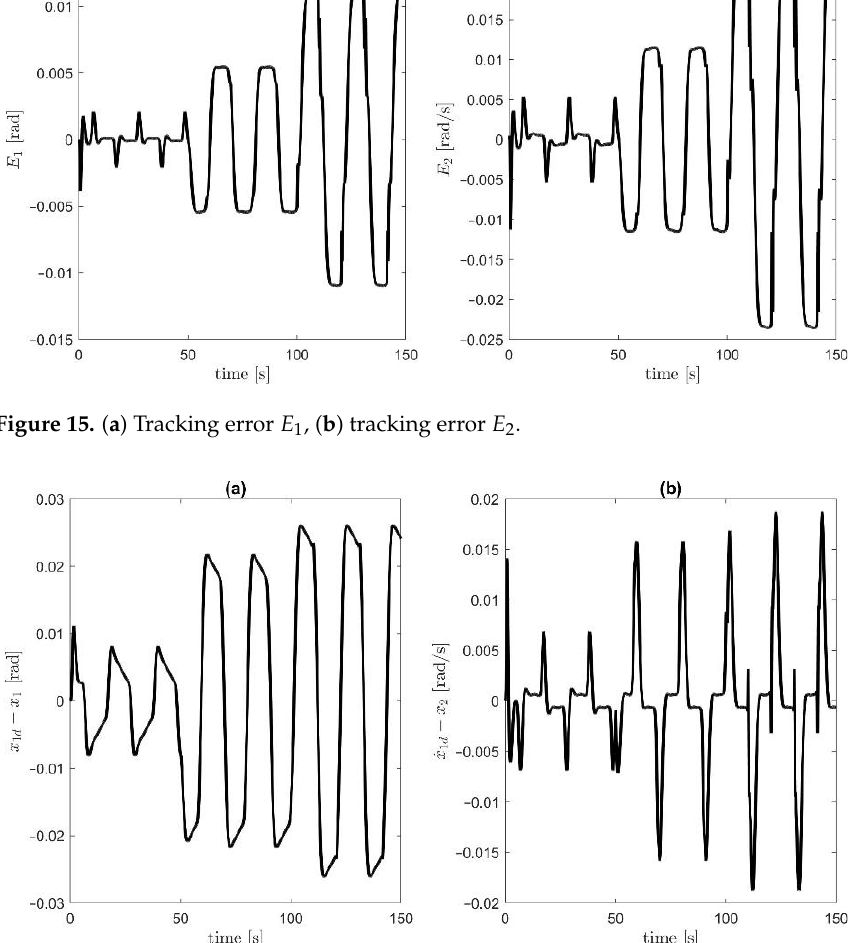
Figure 16. ( a ) Tracking error 𝑥 1𝑑 − 𝑥 1 , ( b ) tracking error 𝑥̇ 1𝑑 − 𝑥 2 .